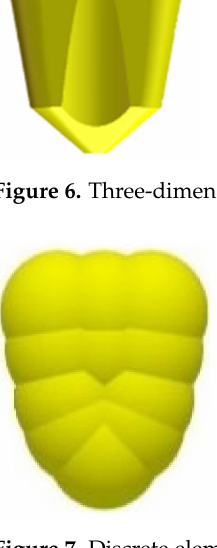
Figure 7. Discrete element simulation model. Table 1. Values of Characteristic Velocity.